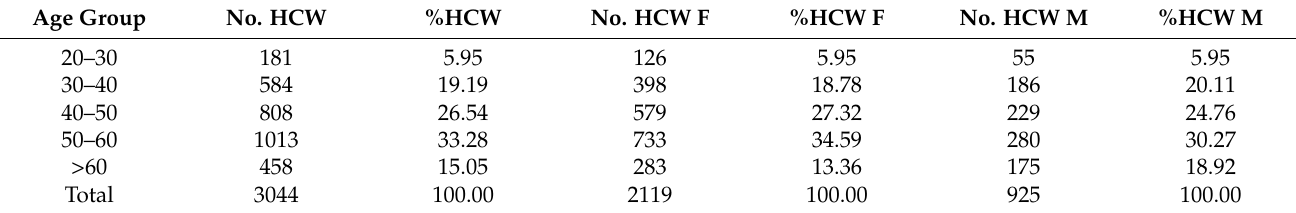
The mean age of the staff is 47.64 years with a standard deviation of ± 10.80 and the most represented age group is 50–60 with 1013 HCWs, of which 733 are females and 280 are males (Table 2). Distribution by macro-area, age group, and gender of AOU-SS HCWs is shown in Table 3. Table 2. Distribution of AOU-SS health workers (HCWs) by gender (F = females; M = males) and age group.